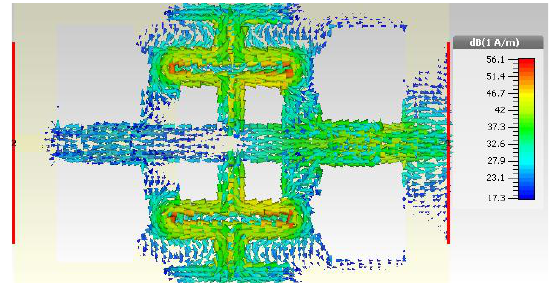
FIGURE 9. Surface current density at 7 GHz.